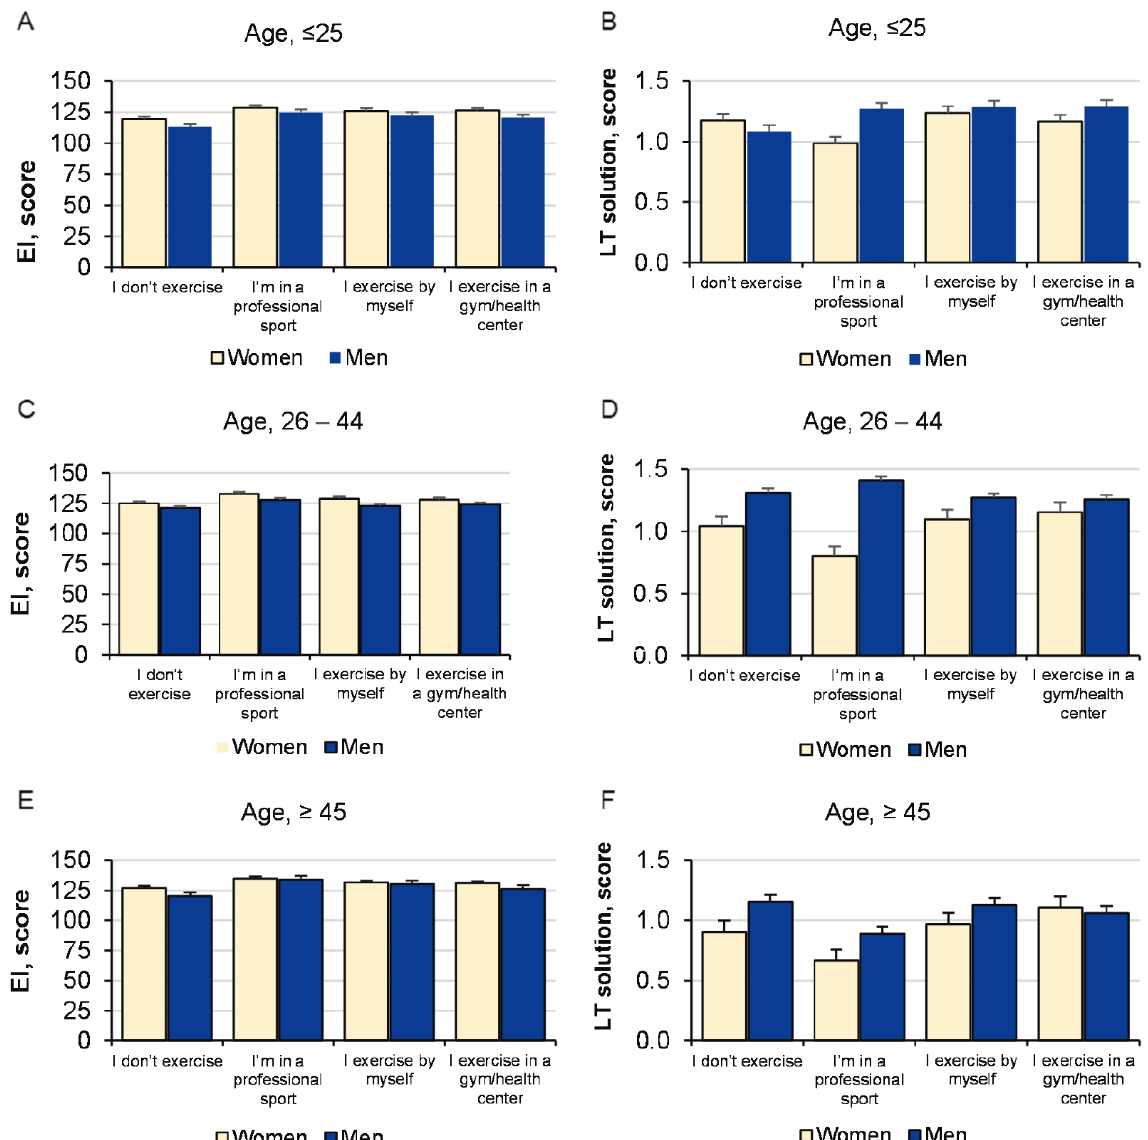
Figure 1. Emotional intelligence ( A , C , E ) and the effectiveness of solving different logic tasks ( B , D , F ) among men and women of different ages (years) who do not exercise, are professional athletes, exercise independently, or exercise at a gym/health center.